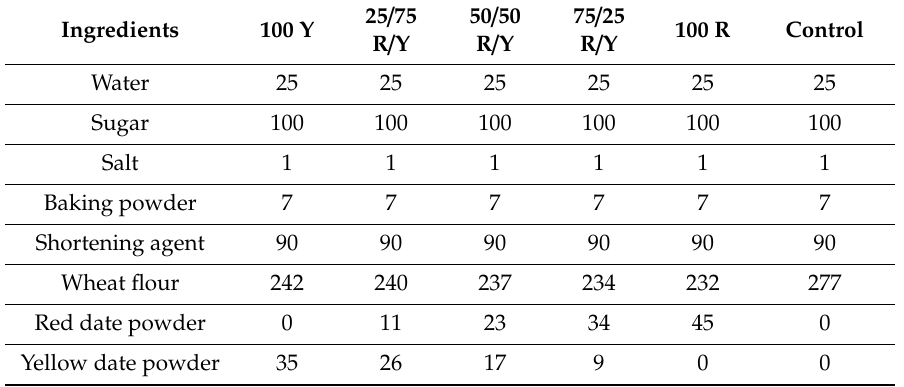
Table 1. Composition (g) of doughs with di ff erent quantities of red (R) and yellow (Y) date powders.